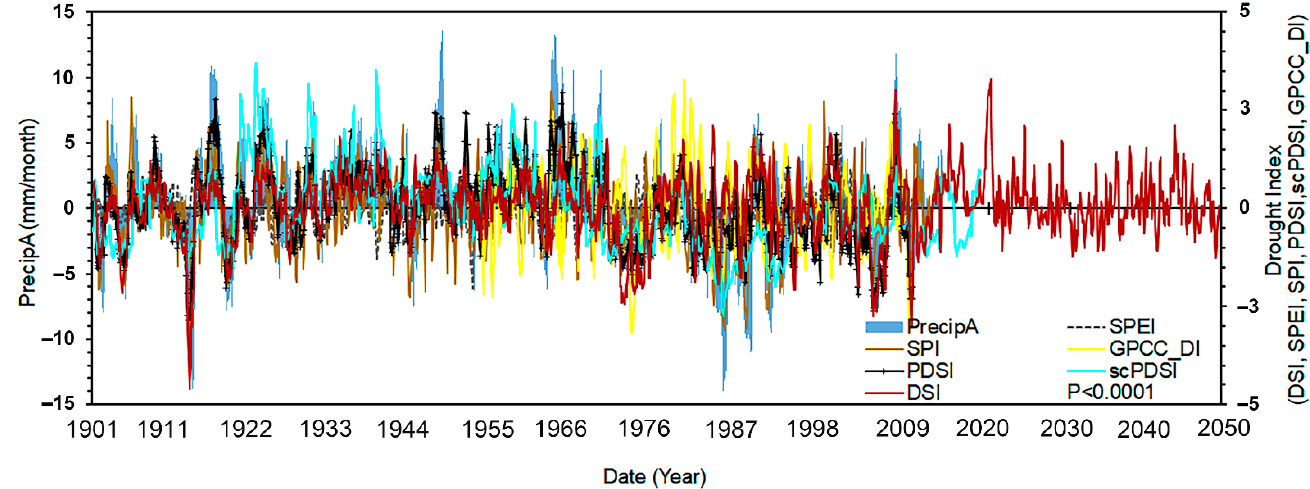
Figure 12. Standardized drought indicators in the NRB compared to precipitation anomalies between 1901 to 2020.